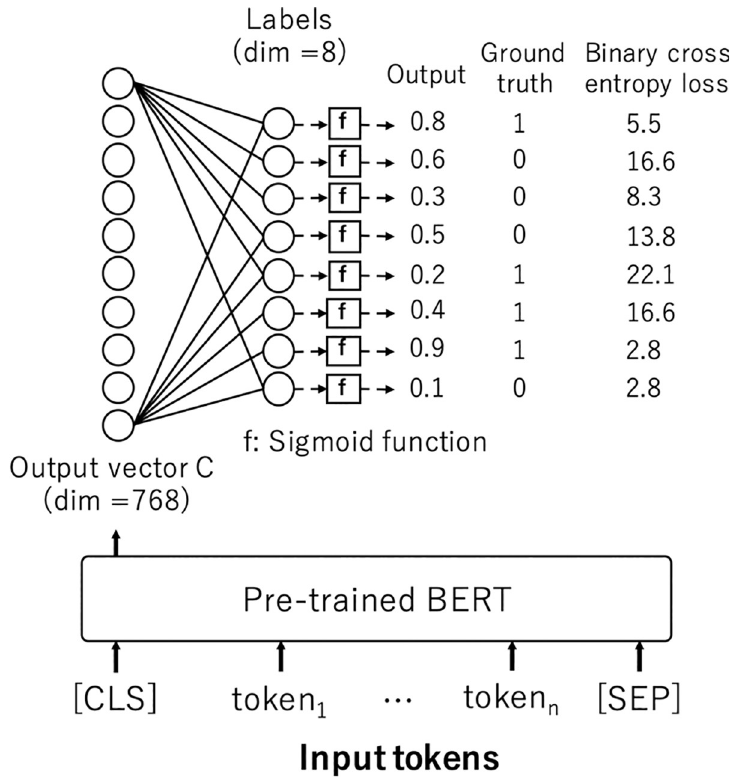
Fig 3. The schematic view of the network for